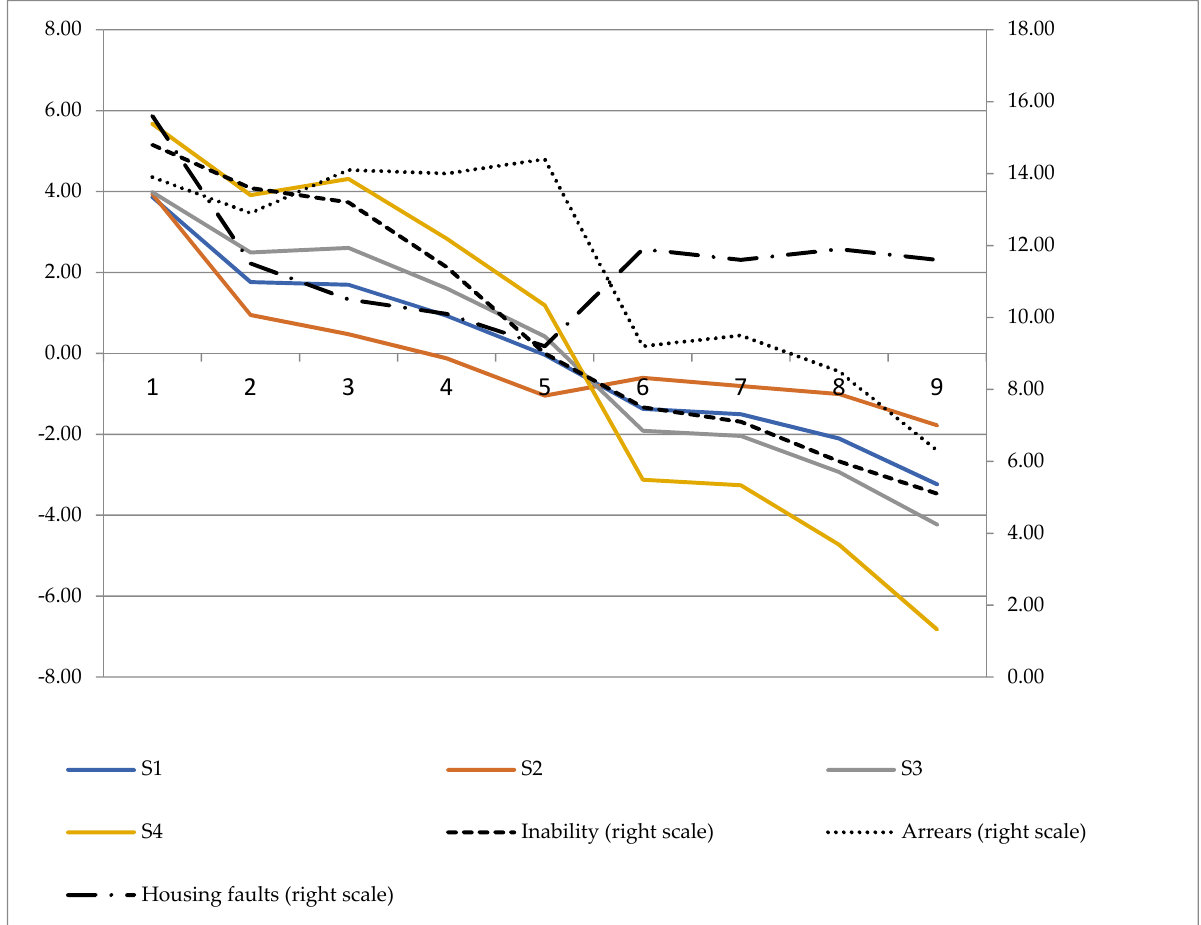
Figure 3. Crude and synthetic indicators of energy poverty. Source: own calculations.